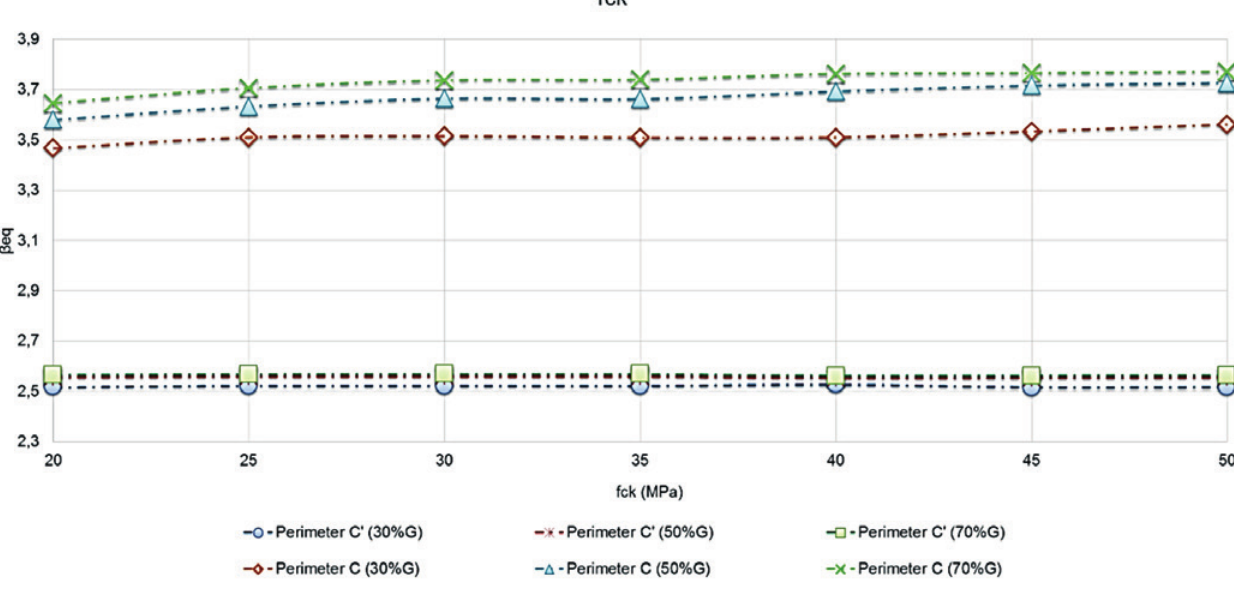
for circular column considering the variation of f eq β